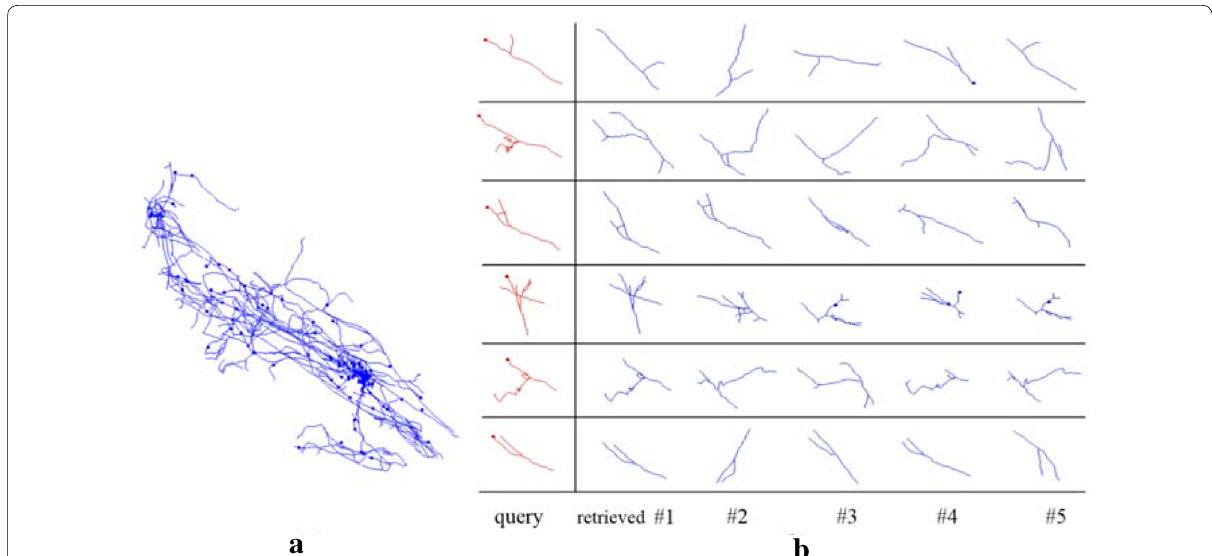
Fig. 6 Query substructures (left column) on a large neuron (80,000